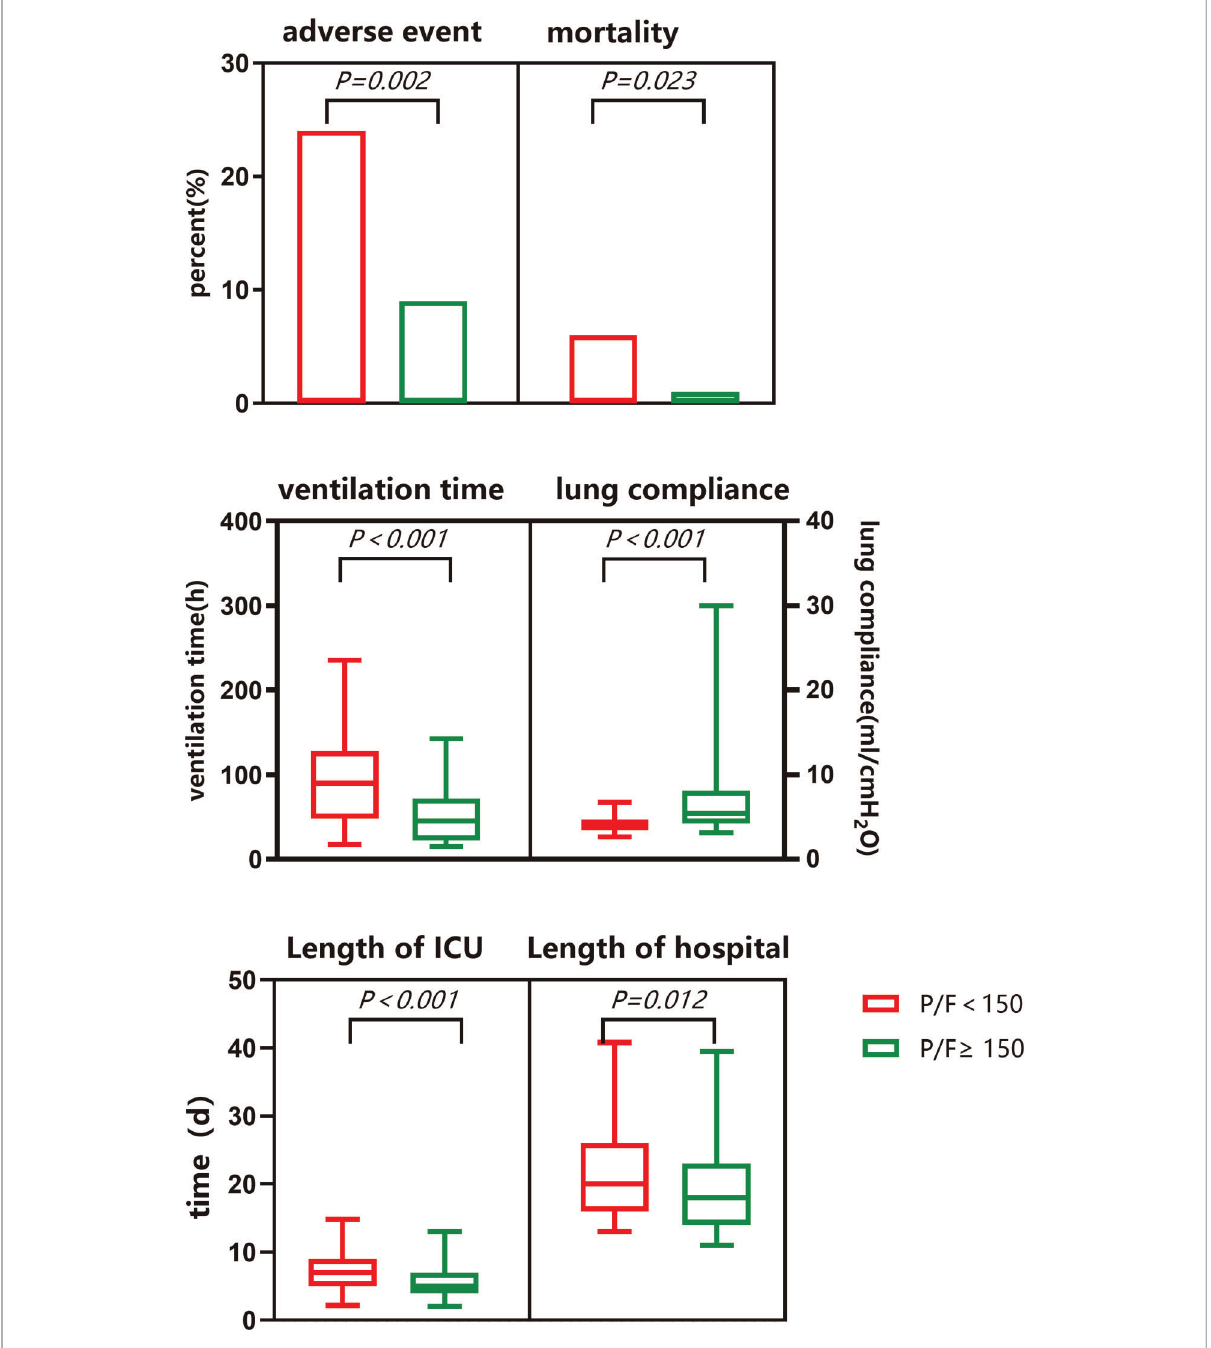
FIGURE 3 Correlation between Postoperative P/F and CPB Time. CPB, cardiopulmonary